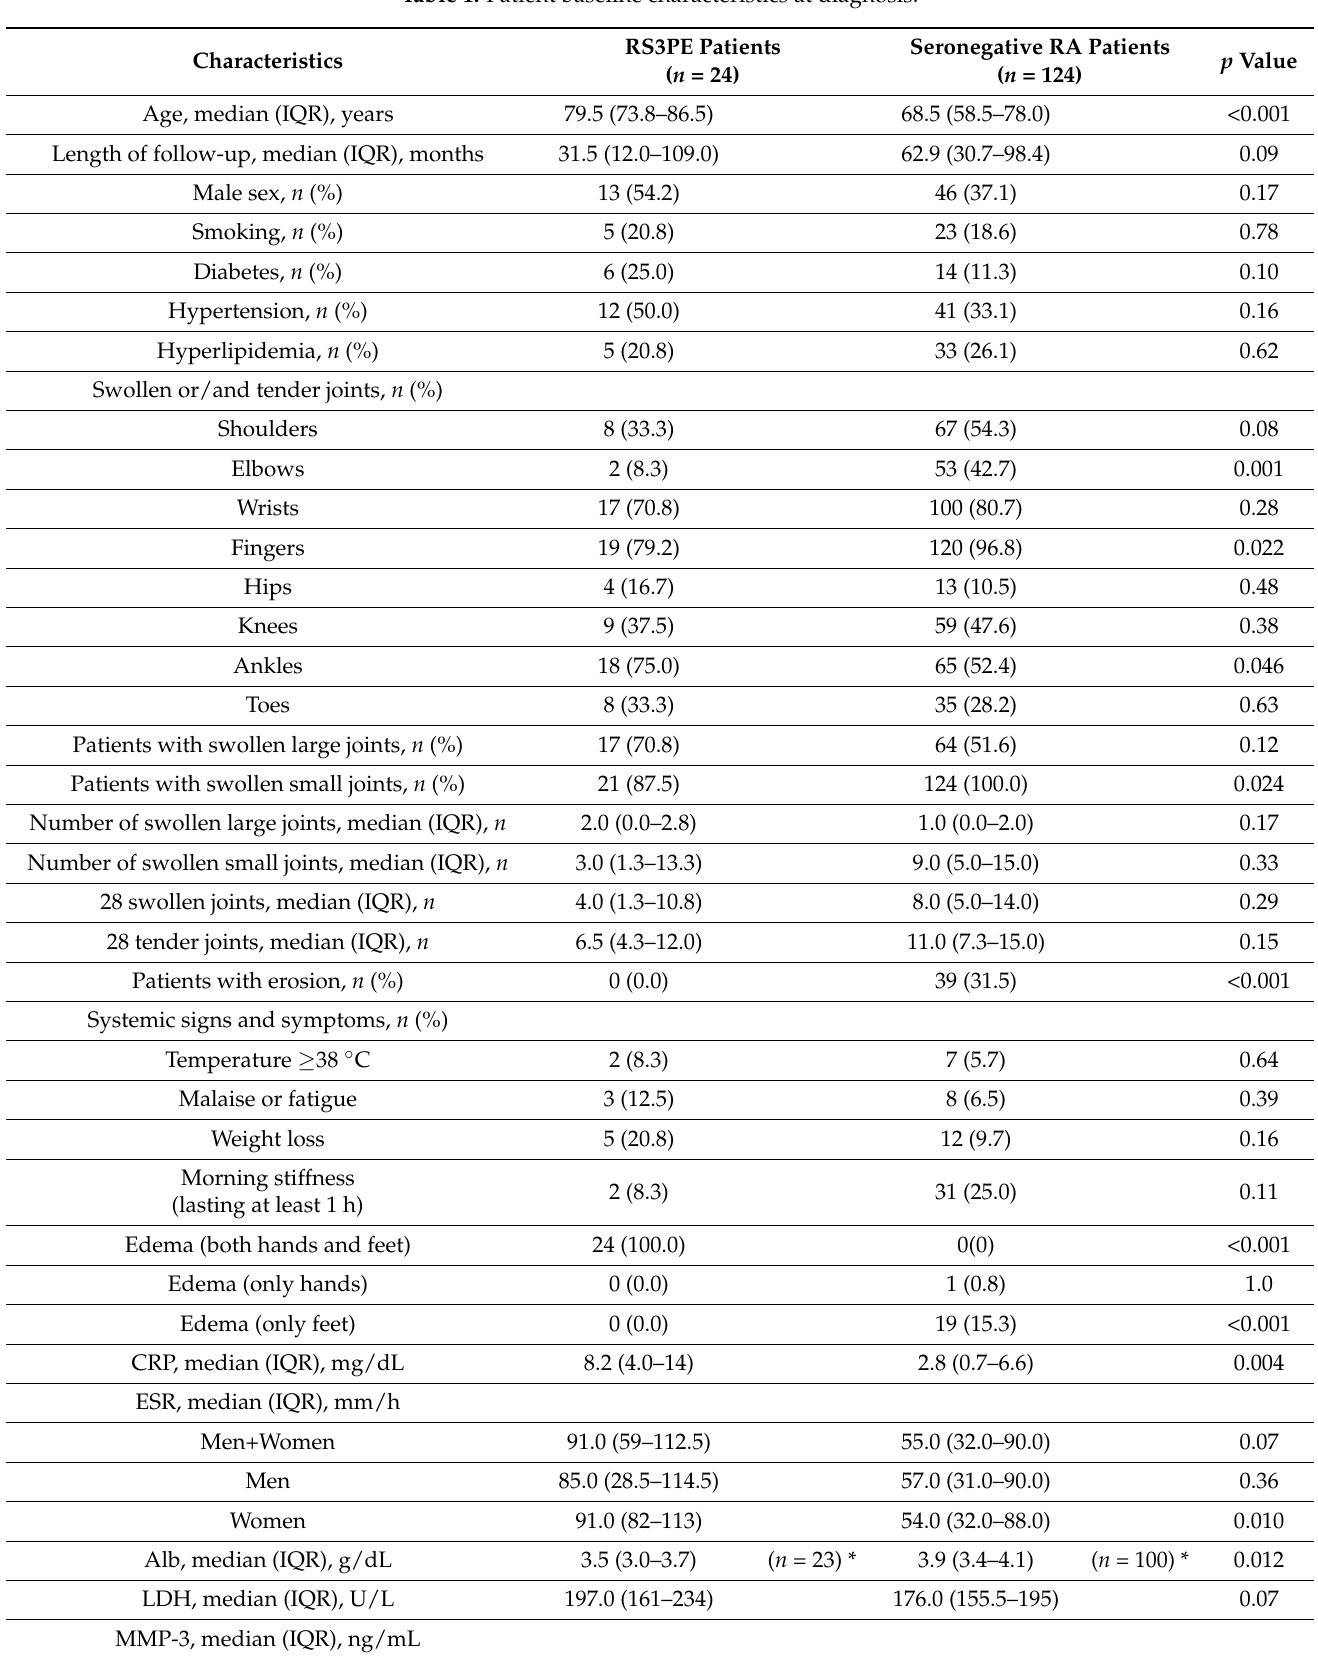
Table 1. Patient baseline characteristics at